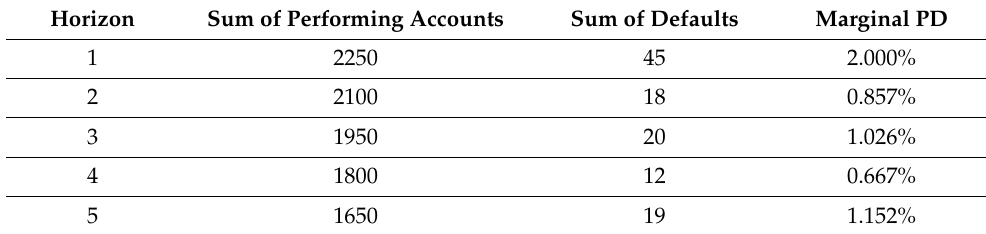
Table 2. Example of the PD term